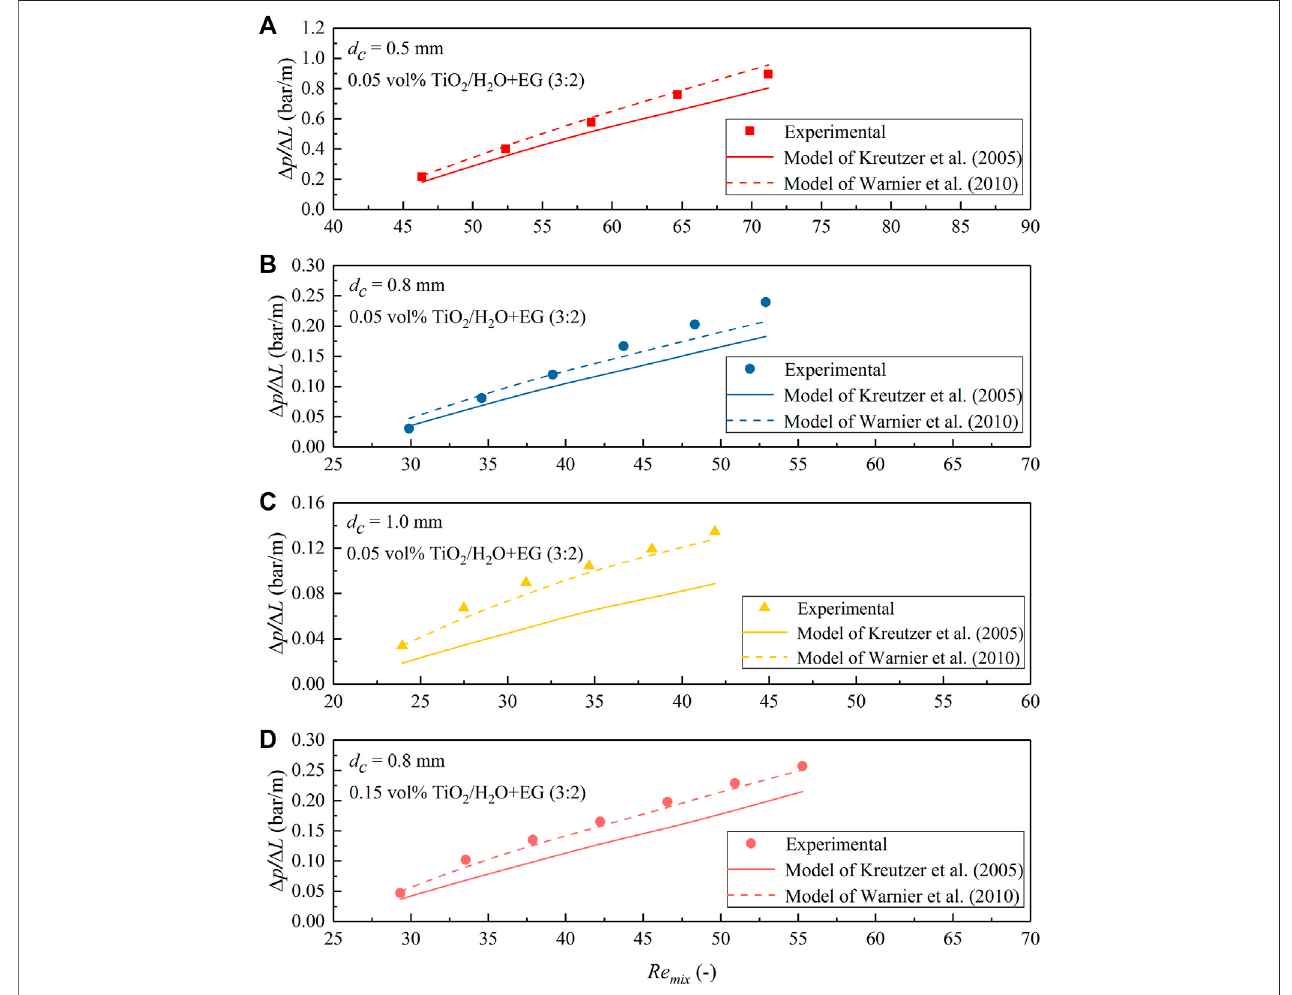
FIGURE14| ComparisonofthemeasuredpressuredropdataforN 2 -TiO 2 /H 2 O + EG(3:2)nano fl uidslug fl owinthemicrochannelwithpredictionsaccordingtothe models of Kreutzer et al. (2005) and Warnier et al. (2010). (A) d c (cid:1) 0.5 mm, φ (cid:1) 0.05 vol%; (B) d c (cid:1) 0.8 mm, φ (cid:1) 0.05 vol%; (C) d c (cid:1) 1.0 mm, φ (cid:1) 0.05 vol%; (D) d c (cid:1) 0.8 mm, φ (cid:1) 0.15